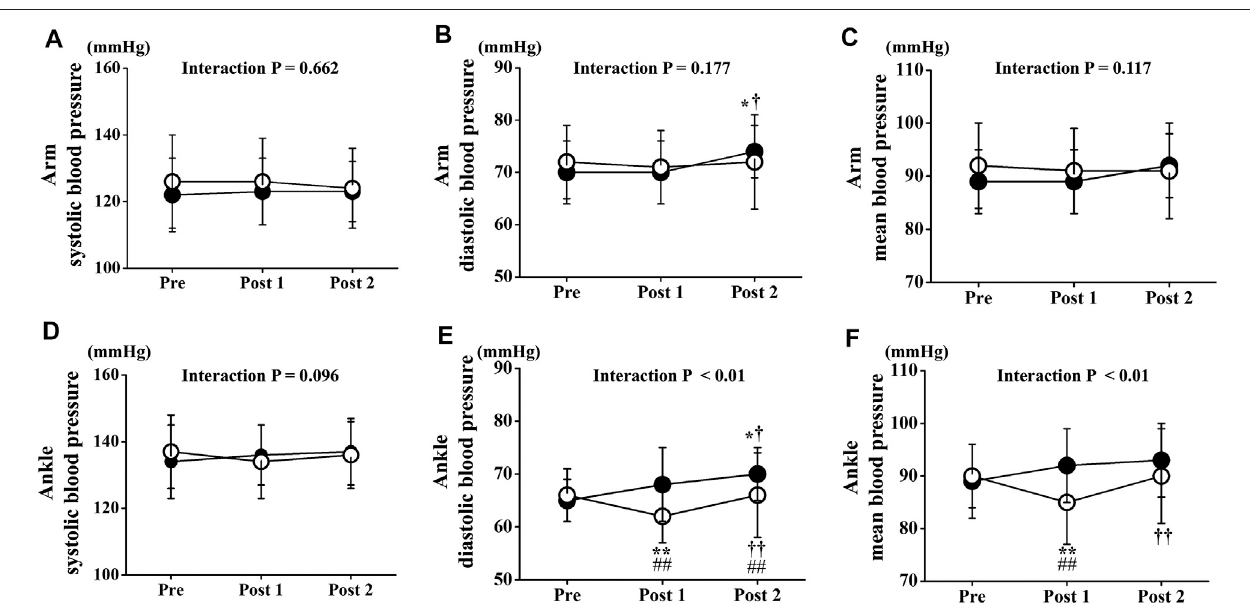
FIGURE 6 | Temporal changes in arm and ankle blood pressure. Arm systolic (A) , diastolic (B) , and mean (C) blood pressure and ankle systolic (D) , diastolic (E) , (cid:129) ),controlrestingtrial;opencircles( ○ ),electricalstimulationtrial;Dataareexpressedasmean±SD. p p < 0.05:vs. andmean (F) bloodpressurearedrawn.Filledcircles( Pre, pp p < 0.01: vs. Pre, † p < 0.05: vs. Post 1, †† p < 0.01: vs. Post 1, # p < 0.05: vs. CT, ## p < 0.01: vs.